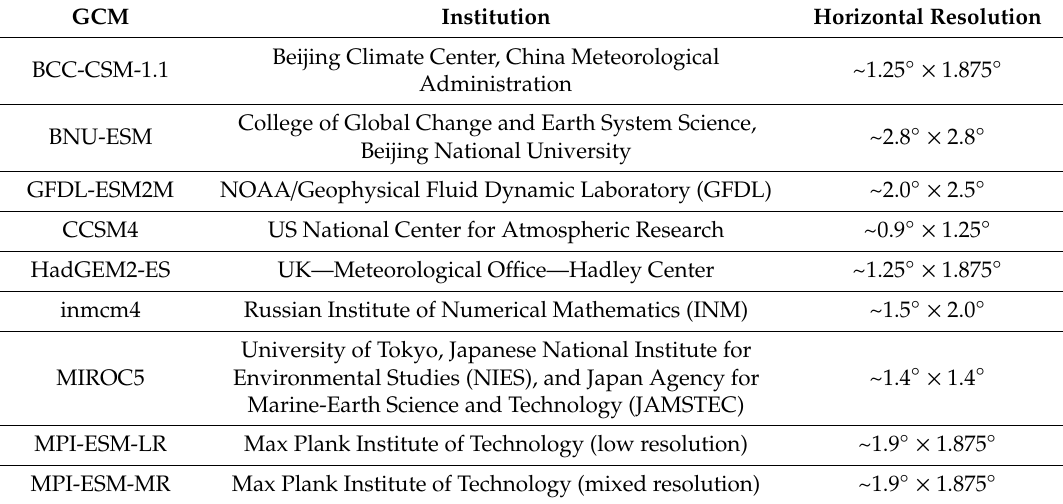
Table 1. Summary of global circulation models (GCMs) used in the